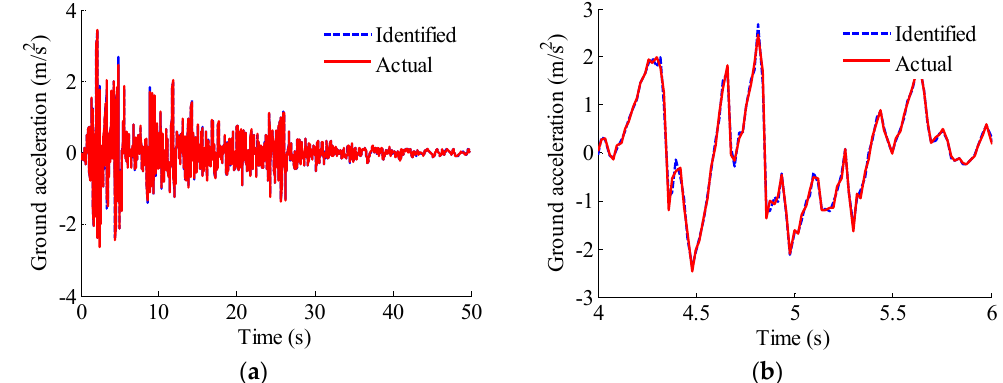
Figure 5. Identified results of the ground acceleration (10% noise): ( a ) the whole time history; ( b ) the time segment from 4 s to 6 s.